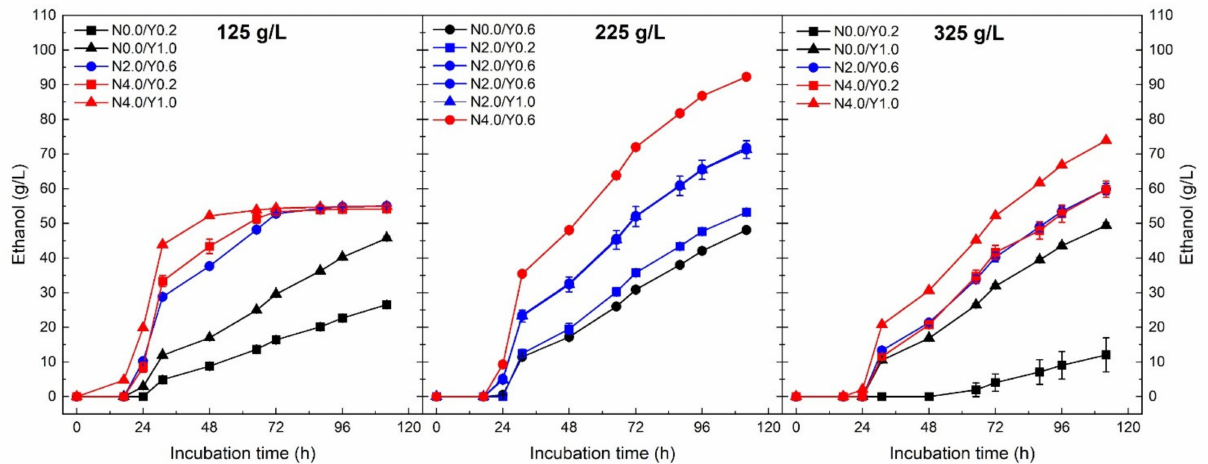
Figure 2. Ethanol production for the different initial sugar concentration of sugar beet molasses (125, 225 and 325 g/L) using Saccharomyces cerevisiae yeast. Colours are attributed to the initial nutrient concentration: black (0.0 g/L), blue (2.0 g/L) and red (4.0 g/L). Symbols are related to the initial yeast concentration: square (0.2 g/L), circle (0.6 g/L) and triangle (1.0